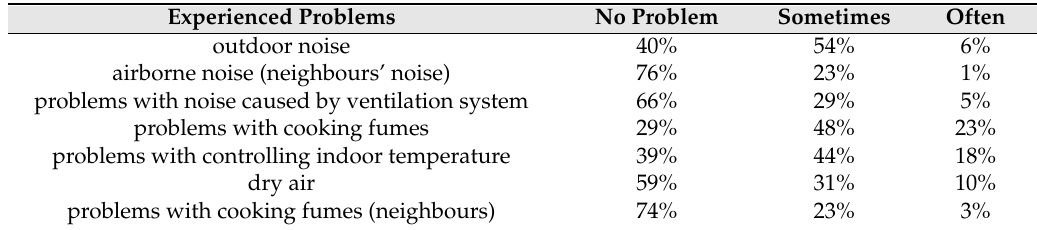
Table 10. Distribution of perceived frequency of experiencing problems with IEQ.